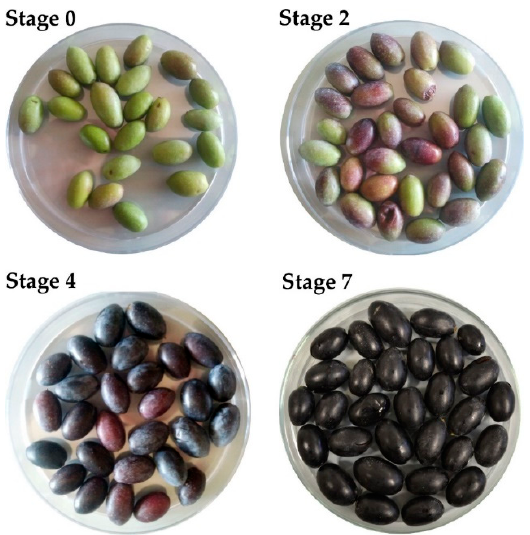
Figure 1. Cellina di Nardò olives. The images represent four of the eight Maturity Index (MI) classification groups (0–7) of olives described by Guzman et al. [16]. Stage 0: green olives; Stage 2: Olive peel partially pigmented and green pulp; Stage 4: dark/black peel and yellow pulp; Stage 7: dark/black peel and pulp.